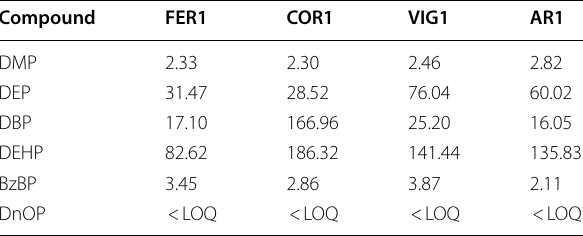
Table 5 Levels of six phthalates expressed in ng g − 1 dry weight coming from four Galician Rías (Ría de Ferrol (FER1), Ría de A Coruña (COR1), Ría de Vigo (VIG1) and Ría de